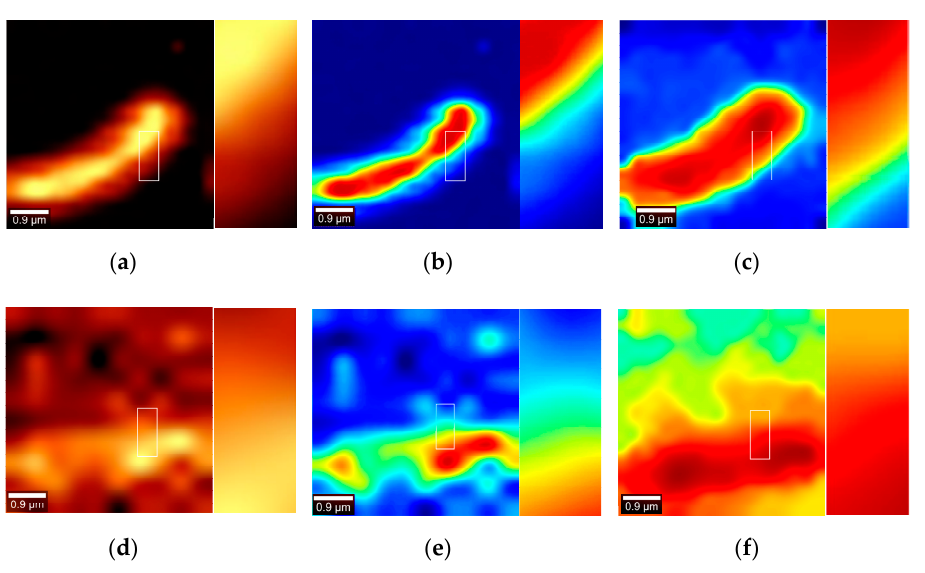
Table 5. The comparison of image information entropy.